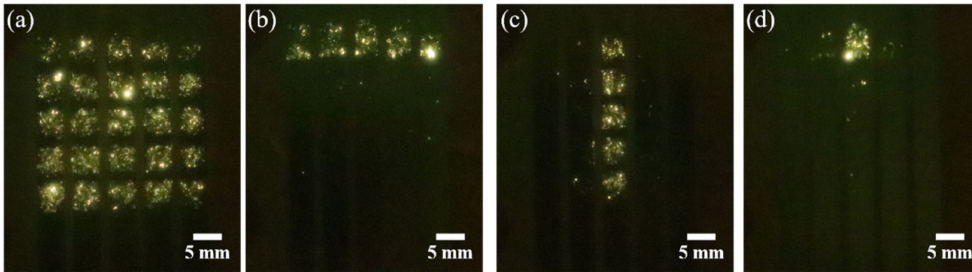
Figure 5. The photograph of visible light emission image at a voltage of 26 kV. ( a ) Full area emission; ( b ) row addressing emission; ( c ) column addressing emission; ( d ) single-pixel addressing emission. The images were taken by a Canon EOS 800D camera with ISO sensitivity, exposure time, aperture, and a focal length of 25,600, 1/4 s, f/4, and 100 mm,